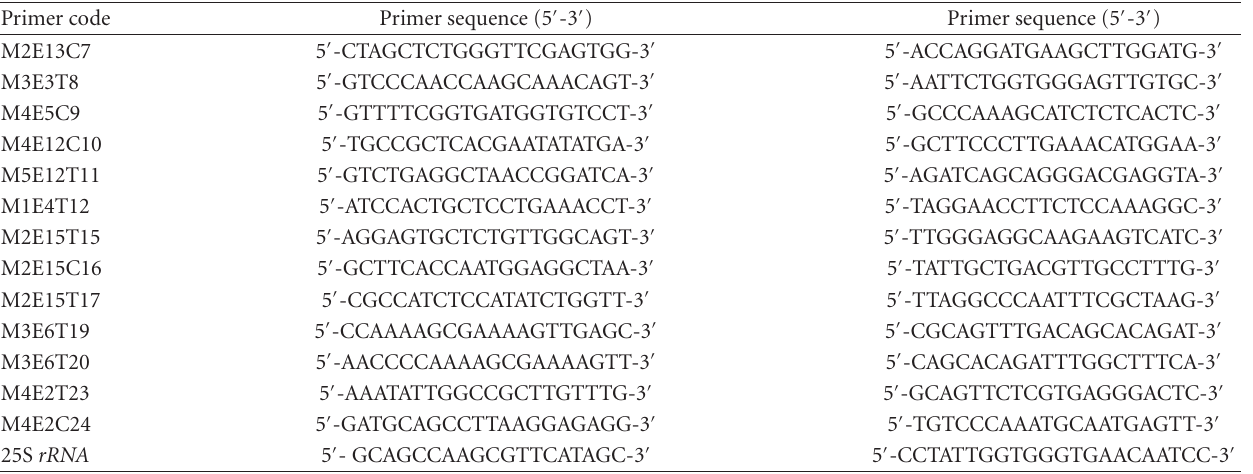
Table 1: Primer sequences used in Real-time PCR analysis.